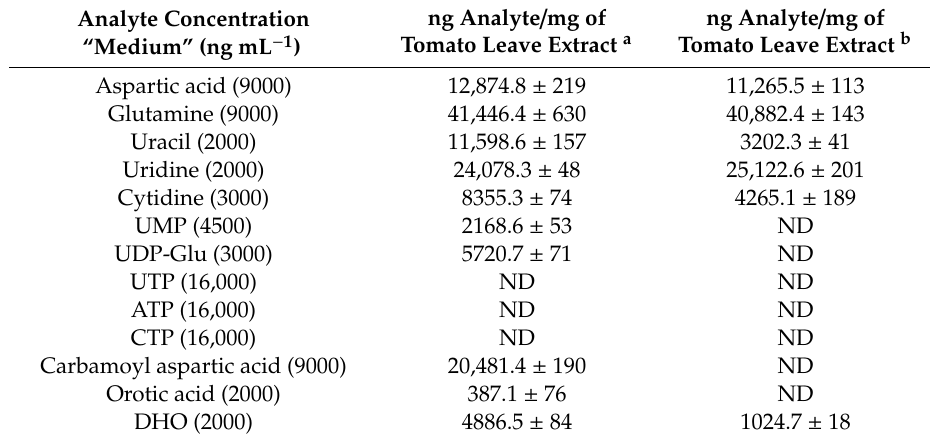
Table 3. Matrix e ff ect of the crude tomato infected leaves extract on the dn SP standards and metabolite concentration; ( n =